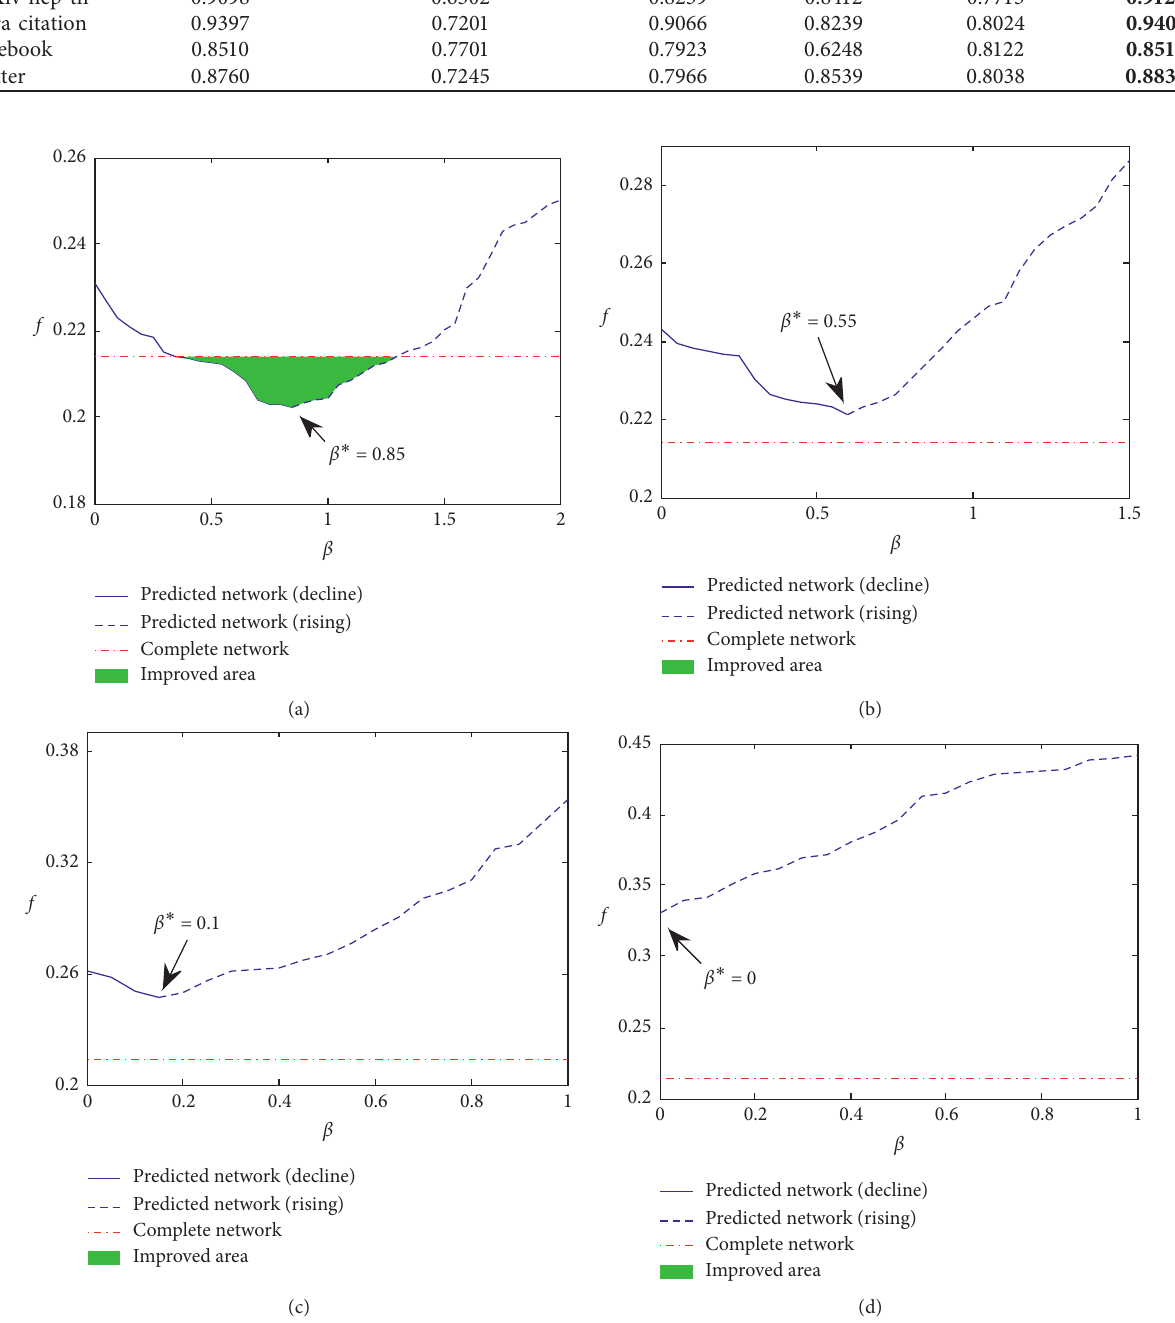
Figure 4: Disintegration evaluation metric as a function of the additional link information ratio with regard to the complete and predicted networks. (a) α � 0.1. (b) α � 0.3. (c) α � 0.5. (d) α �